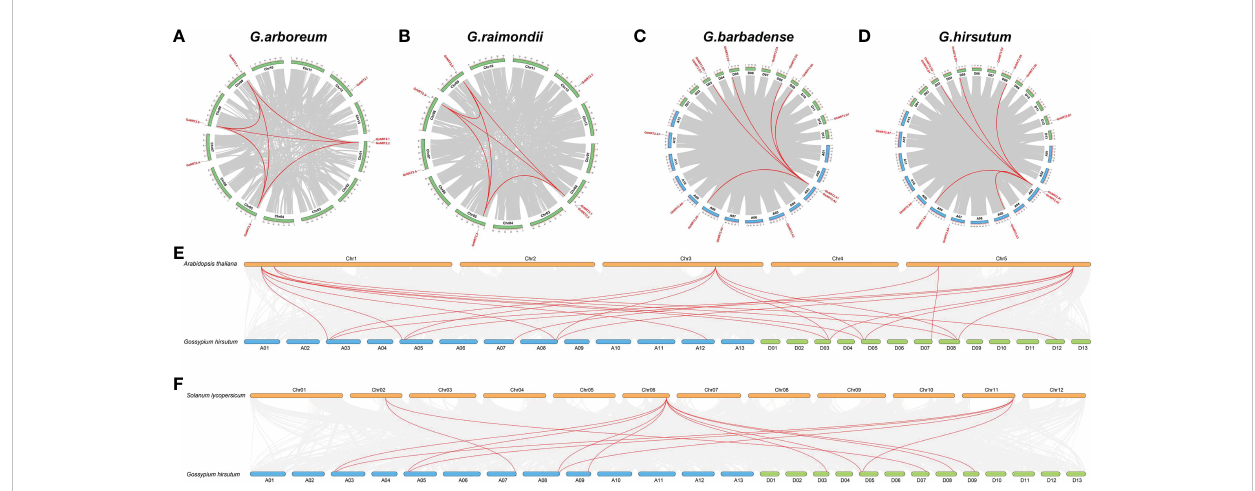
FIGURE 3 Synteny analysis of the GhNRT2s genes. (A) G.arboreum ; (B) G.raimondii ; (C) G.barbadense ; (D) G.hirsutum ; (E) Arabidopsis thaliana and G.hirsutum ; (F) Solanum lycopersicum L. and G.hirsutum